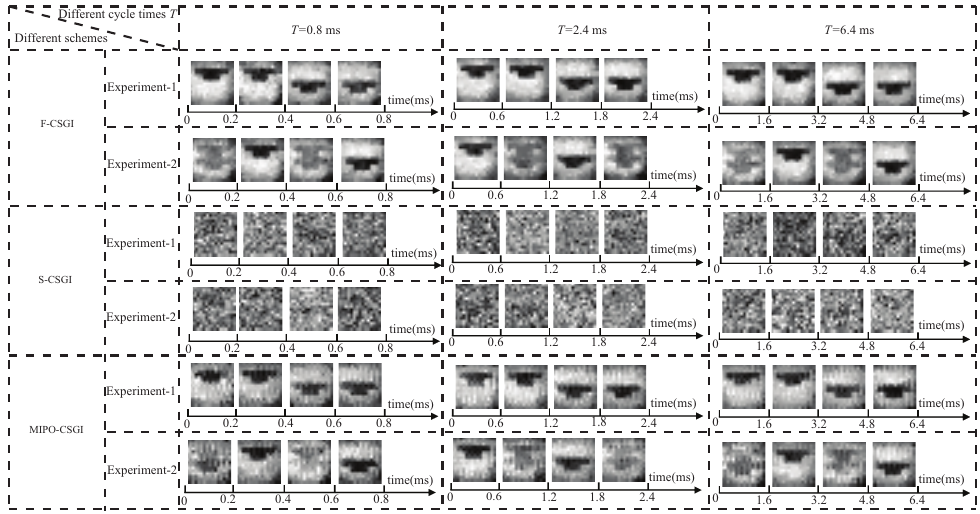
Figure 9. Experimental results of reconstructing four frames of the “ T ” under different cycle times T using F-CSGI, S-CSGI, and